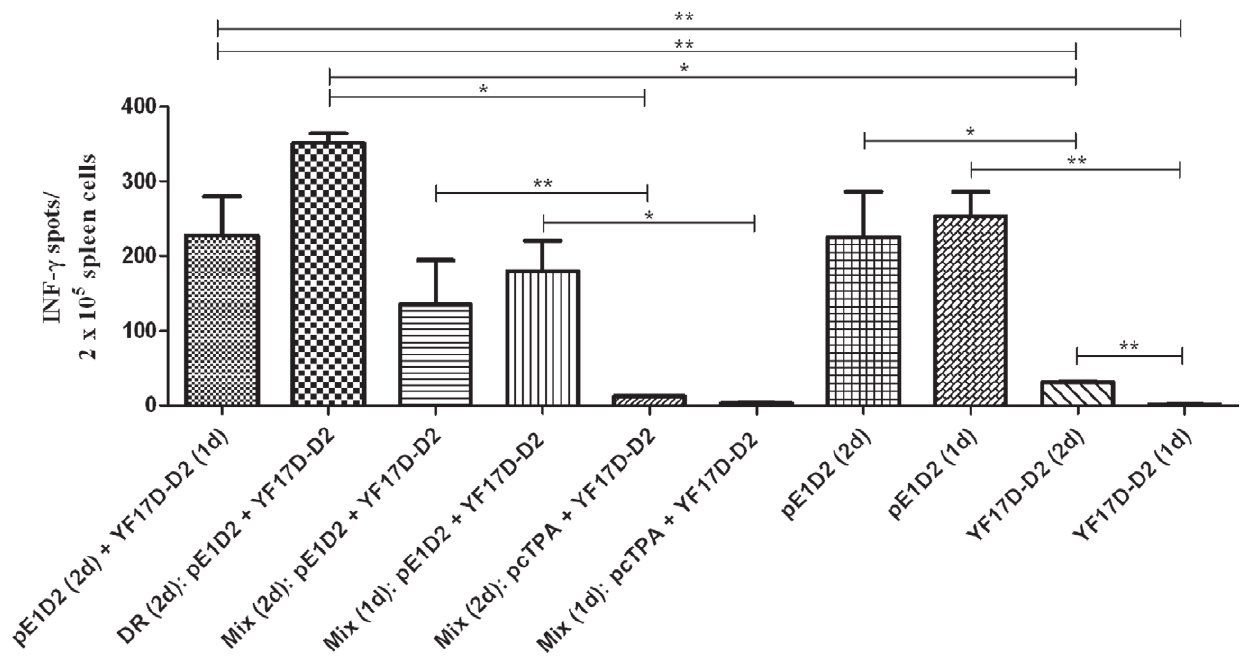
Figure 2. Production of IFN- c by CD8 + T cells from mice immunized with different vaccination protocols. Splenocytes collected from the different animal groups (n=5) were stimulated with a T-cell specific peptide and the number of spot-forming cells (SFC) were quantified in a 24 h ELISPOT assay. Asterisks indicate statistically significant differences using the Mann-Whitney test (*p , 0.05; **p , 0.01). One dose=1d; two doses=2d.